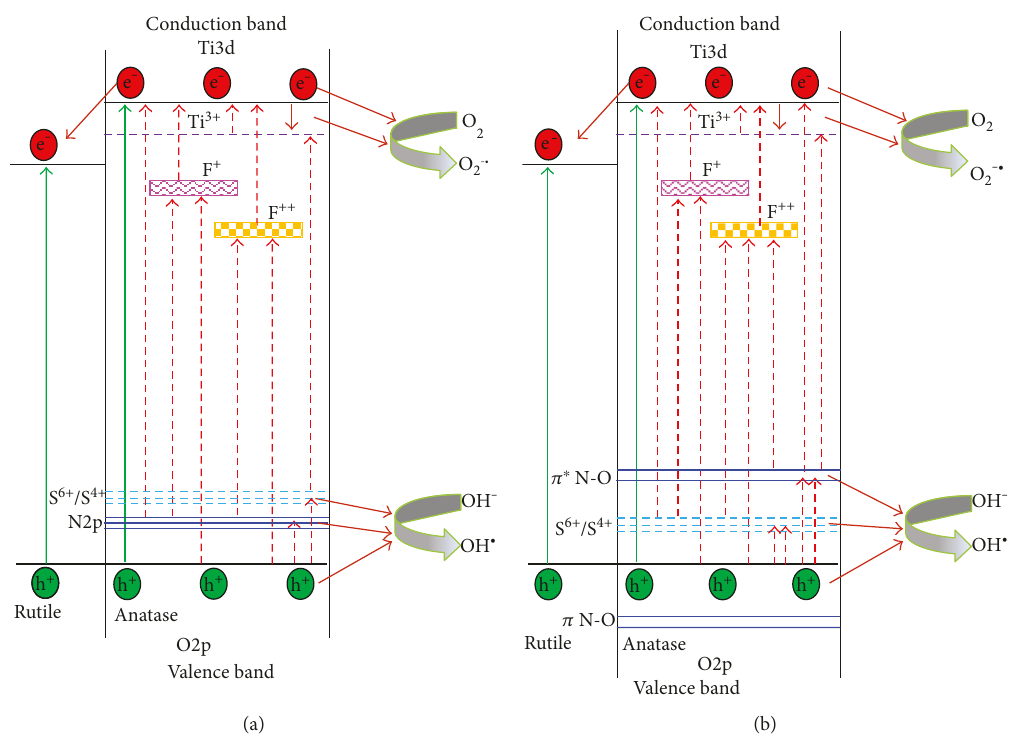
Figure 10: Mechanistic transfer pathways of charge carriers in NS-codoped powders under UV and visible light irradiations (a) substitutional doping of nitrogen and sulphur and (b) substitutional doping of sulphur and interstitial doping of